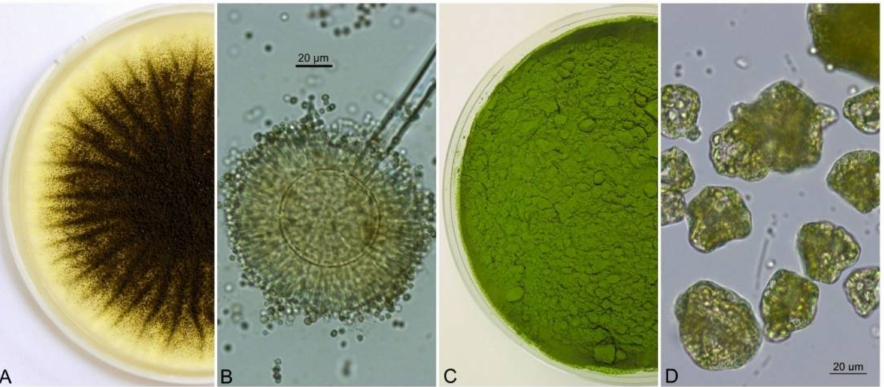
Figure 1. Cultivation of A. niger strain on SDA (Sabouraud Dextrose Agar) ( A ), conidial head with conidiophore terminated by a vesicle with phialides and conidia ( B ), dried culture of the green alga Chlorella sp. ( C ), dried culture of Chlorella sp. under a light microscope ( D